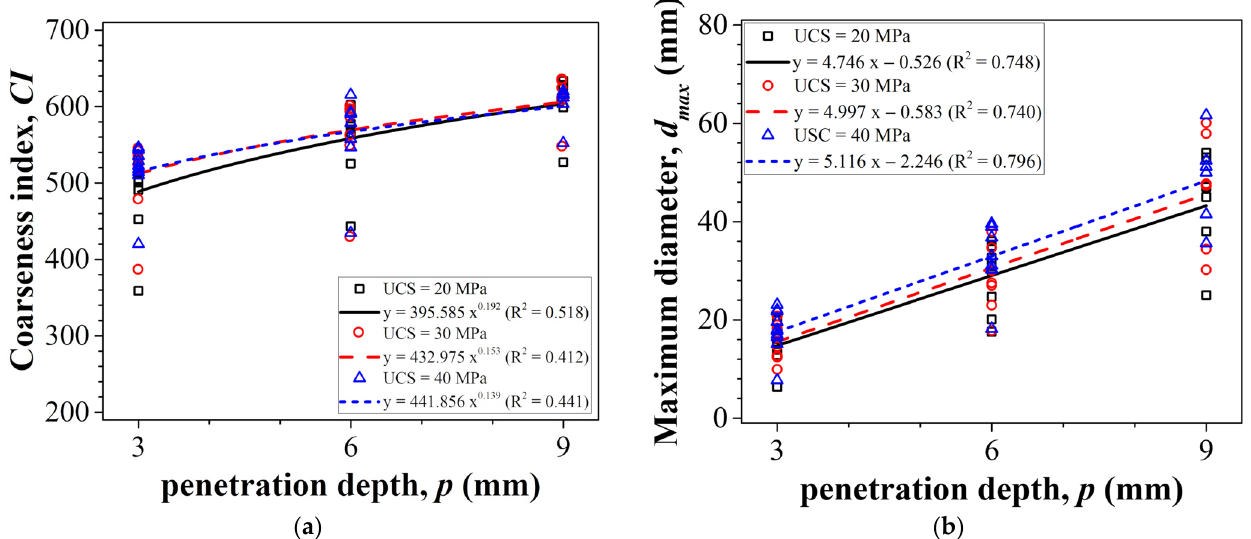
Figure 7. Relationship between penetration depth and ( a ) CI ; ( b ) maximum diameter.